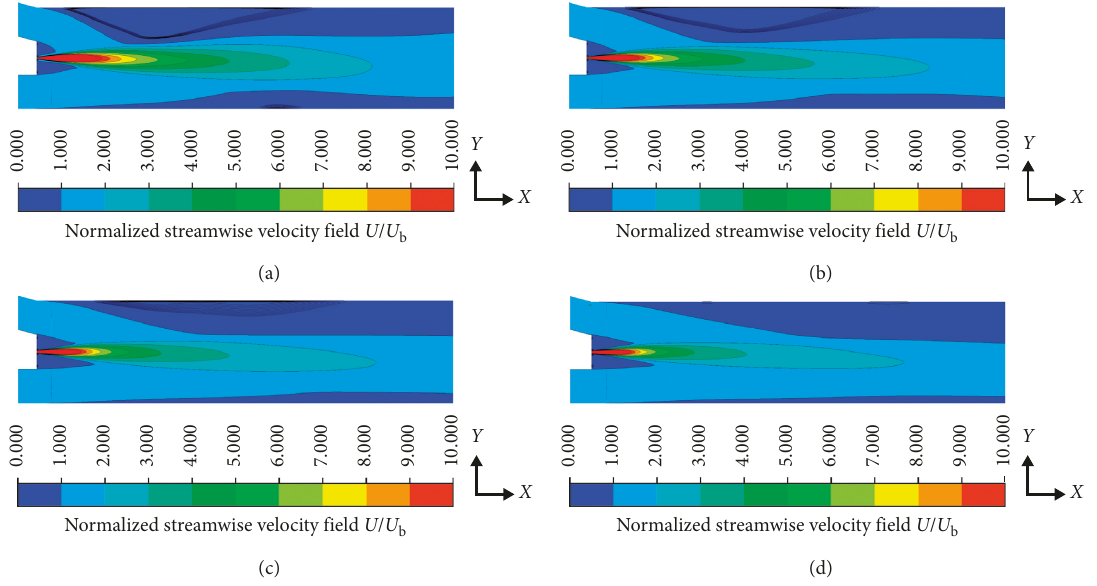
Figure 3: Instantaneous streamwise velocity contours at 5.5 seconds on the symmetry plane XOY: (a) Re � 37240; (b) Re � 29792; (c) Re � 24827; (d) Re � 21280.